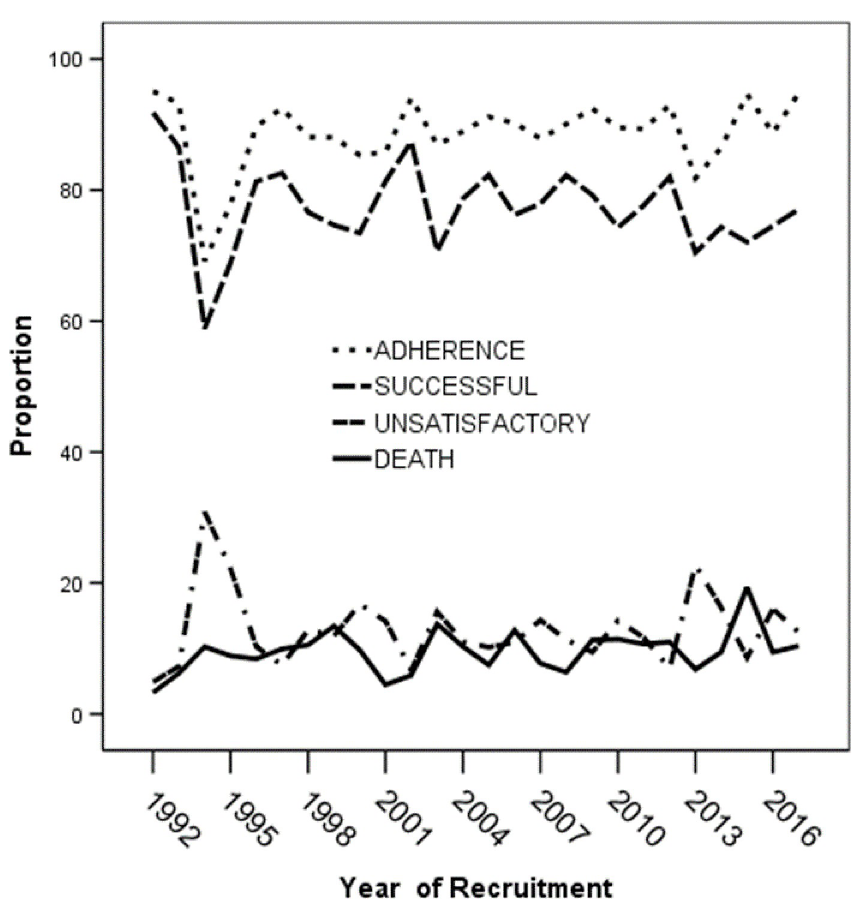
Fig 4. Showing annual treatment outcomes for TB treatment. Successful treatment outcome = cure+ treatment completed; Potentially Unsatisfactory outcome = default + transferred out + treatment failure.